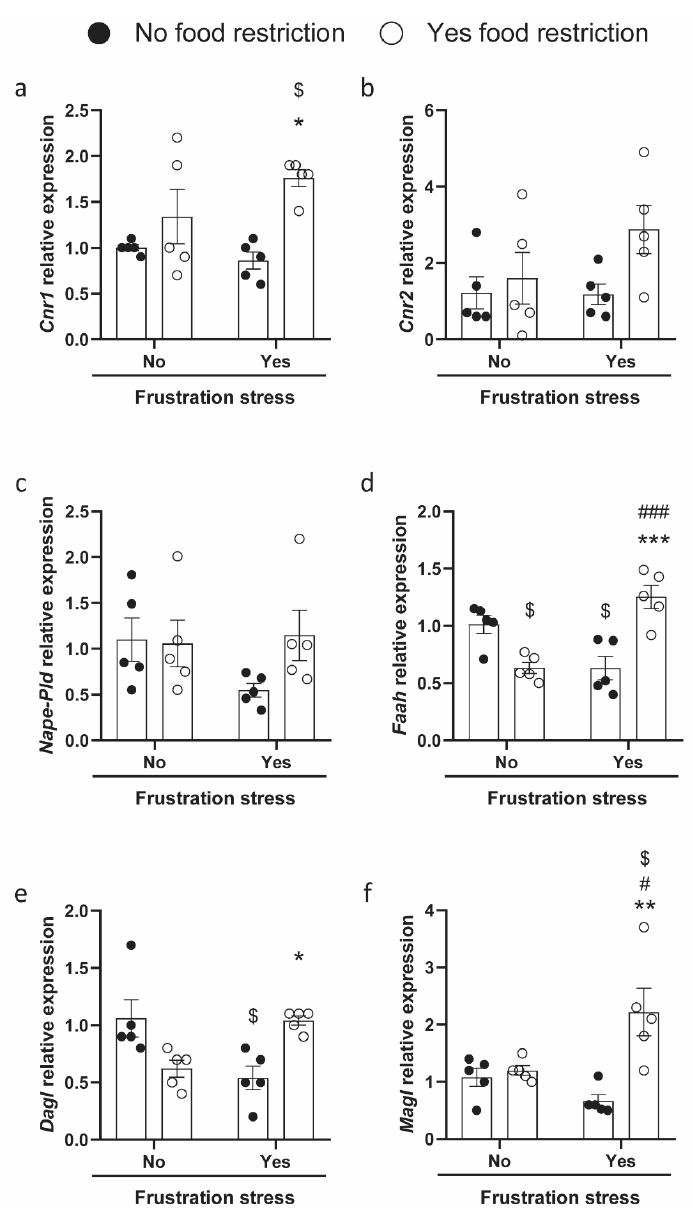
Figure 2. ECS relative gene expression in the hypothalamus of rats exposed (or not) to restriction and stress (NR + NS: Non-restricted and Non-stressed rats; NR + S: Non-restricted and Stressed rats; R + NS: Restricted and Non-stressed rats; R + S: Restricted and Stressed rats) reported as 2 − ΔΔ Ct values calculated by Delta–Delta Ct ( ΔΔ Ct) method versus NR + NS animals posed equal to 1. Expression was normalized using an average CT-value from both reference genes (GAPDH and β -ACT), and data are reported as mean ± SEM; n = 5 per group. Relative expression of: ( a ) Cnr1 (cannabinoid type-1); ( b ) Cnr2 (cannabinoid type-2); ( c ) Nape-Pld (N-acyl-phosphatidylethanolamines hydrolyzing phospholipase D; ( d ) Faah , (fatty acid amide hydrolase); ( e ) Dagl , (sn-1-specific diacylglycerol lipase); ( f ) Magl , (monoacylglycerol lipase). Data were analyzed by two-way ANOVA in a 2 (food restriction: no, yes) x 2 (frustration stress during testing: no, yes) factorial design. Bonferroni’s post hoc tests were used to follow up on significant interaction or main effects ( p < 0.05) from the factorial ANOVAs. Significant differences are indicated: $ p < 0.05 versus NR + NS, # p < 0.05 versus R + NS, ### p < 0.001 versus R + NS, * p < 0.05 versus NR + S, ** p < 0.01 versus NR + S, *** p < 0.001 versus NR +